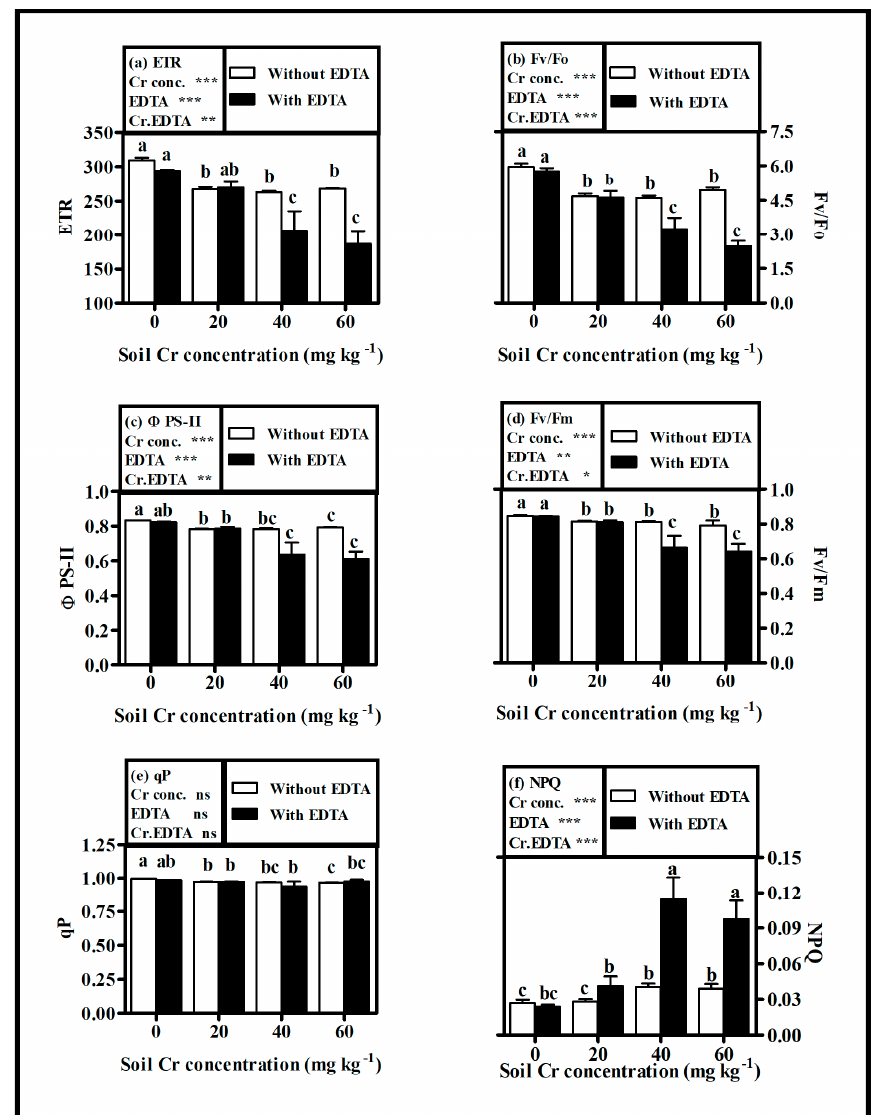
Figure 2. Influence of various Cr(VI) concentrations in soil on chlorophyll- α fluorescence parameters: ( a ) apparent electron transport rate (ETR), ( b ) potential activity of PSII (Fv/Fo), ( c ) effective quantum yield of PSII ( Φ PSII) ( d ) maximal PSII photochemical efficiency (Fv/Fm) ( e ) photochemical quenching (qP) and ( f ) non-photochemical quenching (NPQ or qN) of hybrid Napier grass with and without EDTA application. Bars with dissimilar letters are significantly different at p < 0.05 from Tukey’s test. Values are means ± SE, n = 5. * p < 0.05; ** p < 0.001; *** p ≤ 0.001. ns: non-significant, Cr conc.: soil Cr(VI) concentration effect; EDTA: EDTA effect and Cr conc. EDTA: Cr(VI) conc. × EDTA interaction effect.